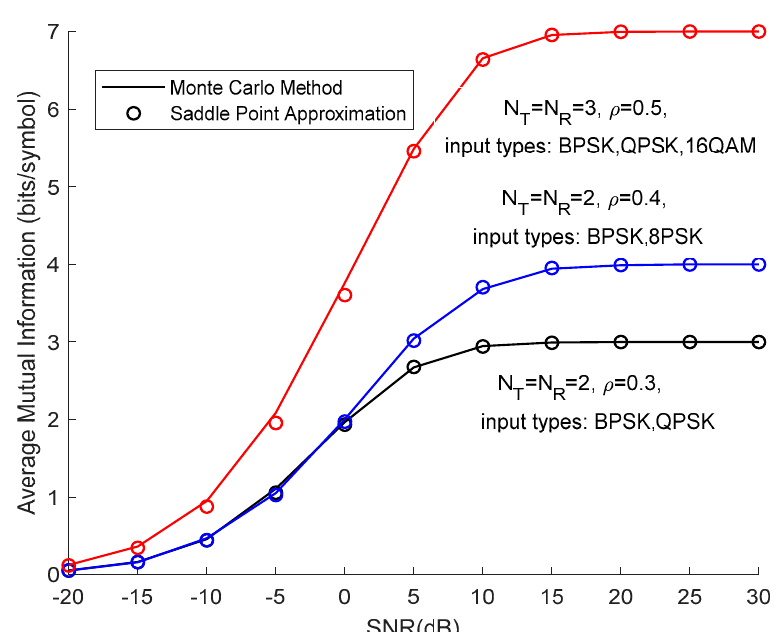
Figure 1. Comparison on MI calculated by Monte Carlo and saddle point approximation under different input types and correction parameters ( ρ T = ρ R = ρ ) over doubly correlated Rayleigh fading channel model.